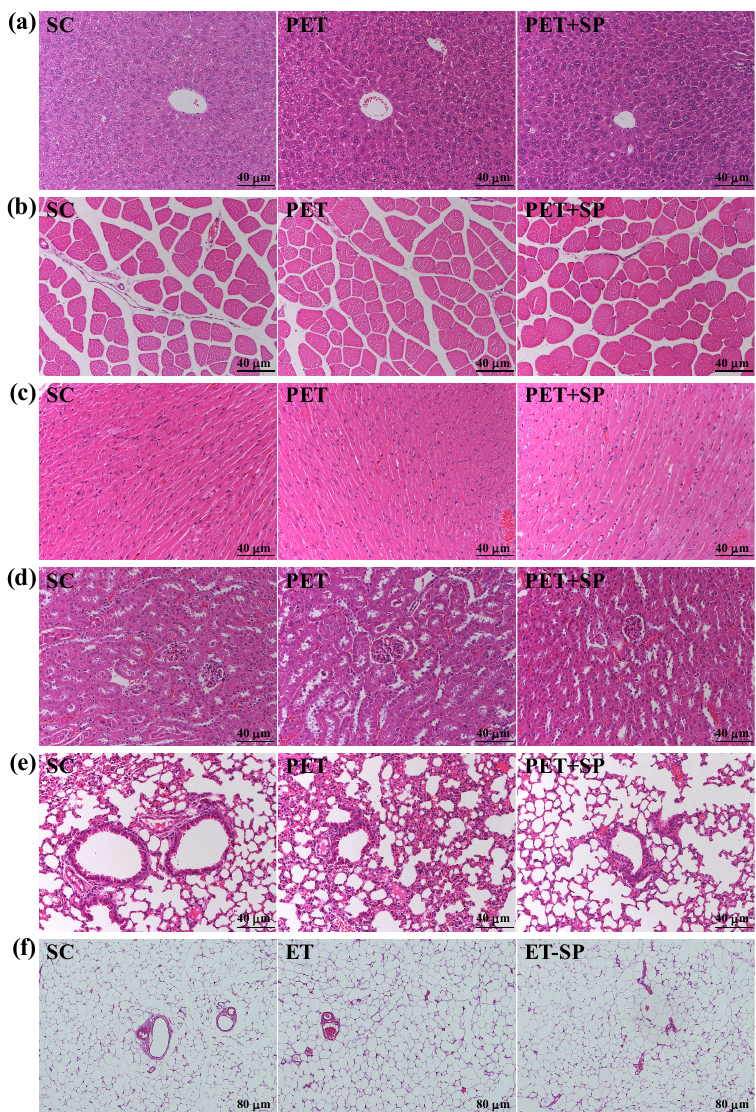
Figure 8. Effect of PET and PET + SP on the morphology of ( a ) liver, ( b ) skeletal muscle, ( c ) heart, ( d ) kidney, ( e ) lung and ( f ) epididymal fat pad (EFP) tissues. Specimens were photographed with a light microscope (Olympus BX51). (H & E stain, magnification: a ‐ e, ×200, Scale bar, 40 μ m; f, ×100, Scale bar, 80 μ m).